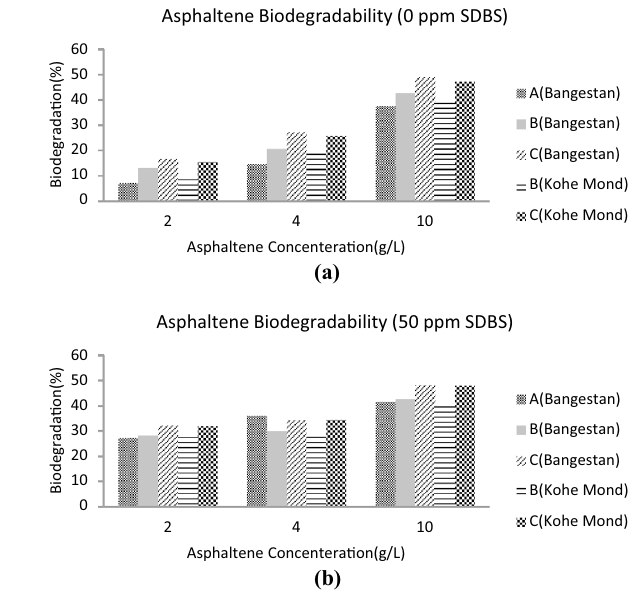
Fig. 7 Hydrophobicity of three types of microorganisms at different initial Ahwaz-Bangestan asphaltene concentrations: a without SDBS presence and b with SDBS presence